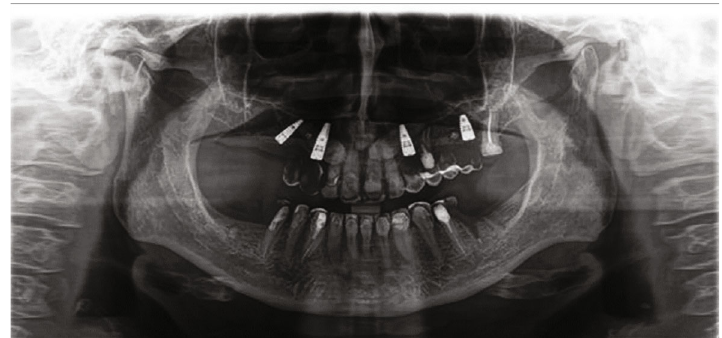
Figure 8: Panoramic image 3 months postop.